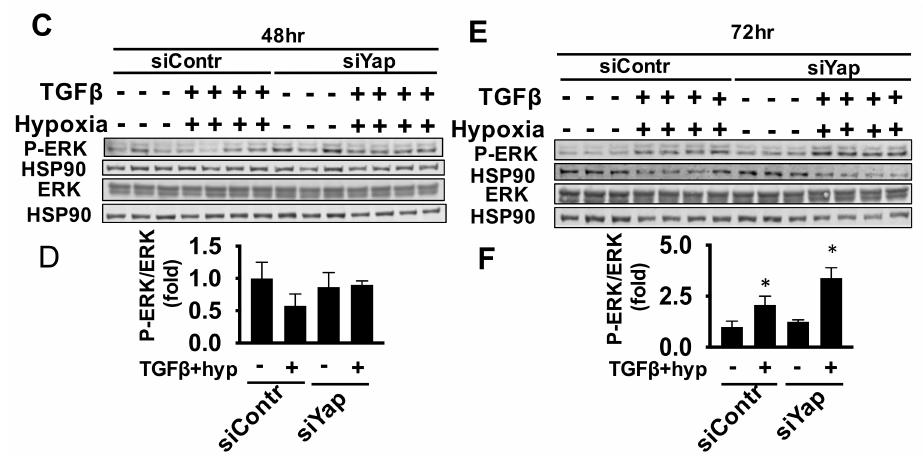
Figure 6. Elevation of ERK1/2 under conditions of HF is not ameliorated upon gene silencing of Yap. ( A ) Representative immunoblot for indicated proteins of LV tissues from HF patients and non-failing controls and ( B ) corresponding densitometry quantitative analyses. P-Erk: phospho- Erk. Data represent mean ± S.E.M of fold changes from control; n = 7 subjects/group, * p < 0.05 vs. control. ( C – F ) Human adult cardiac fibroblasts were transfected with siYap or siContr and exposed to hypoxia/TGF β for stated durations and immunoblot analyses performed to detect indicated proteins. ( D , F ) Graphs representing quantitative densitometry analysis normalized to corresponding loading control. Data represent mean ± S.E.M of fold changes from siContr-infected vehicle-treated control group ( − ); n = 3–4/condition, * p < 0.05 vs. corresponding ( − )